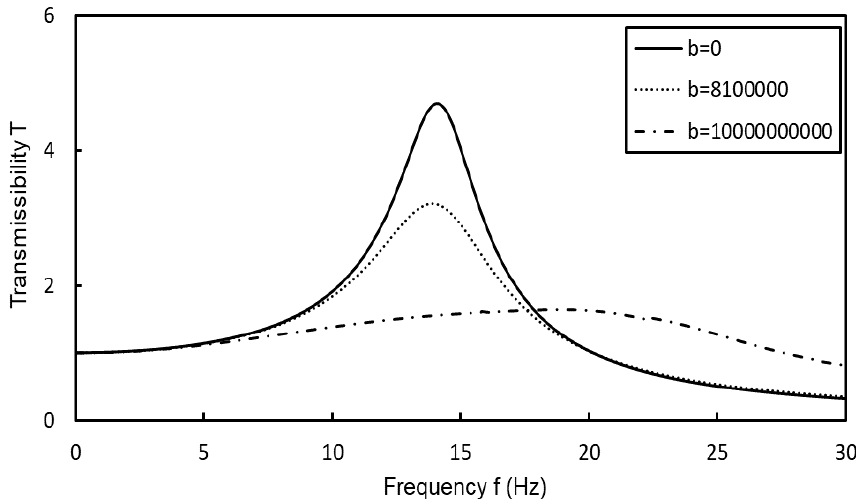
Figure 11. Transmissibility of the non-linear stiffness isolator module of VEAM with varying values of b .